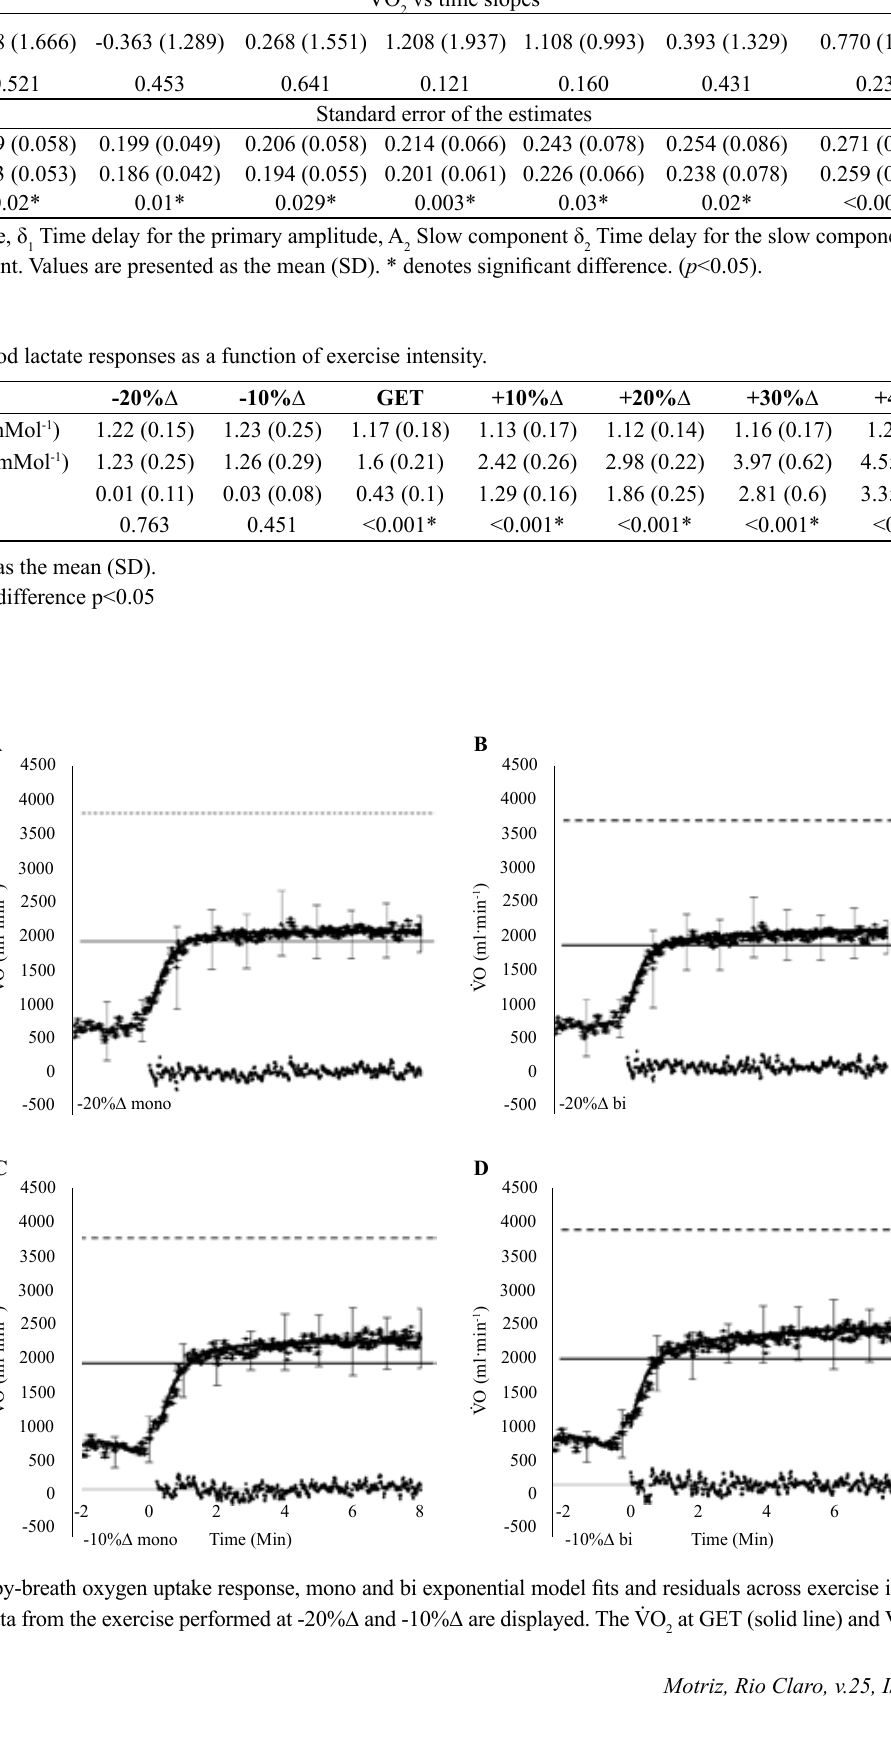
at GET (solid line) and V ̇ O (dashed 2 2peak